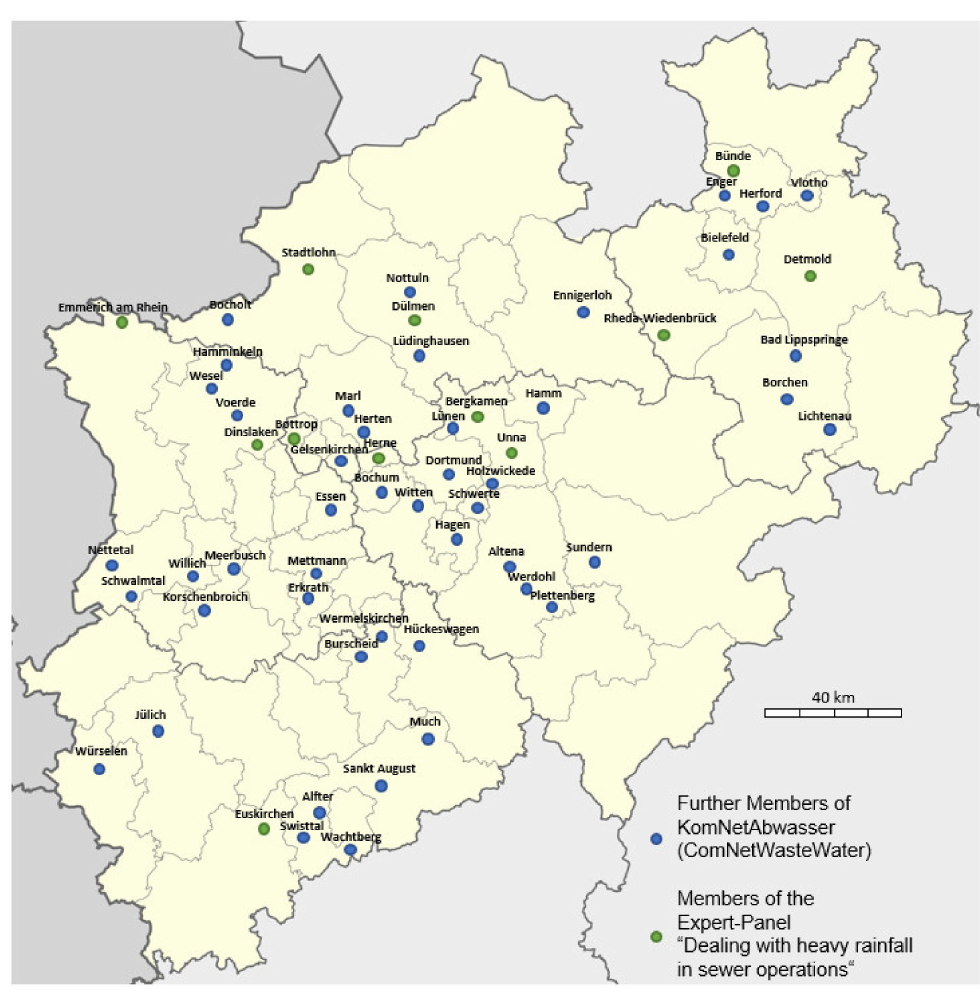
Figure 1. KomnetAbwasser members (including expert